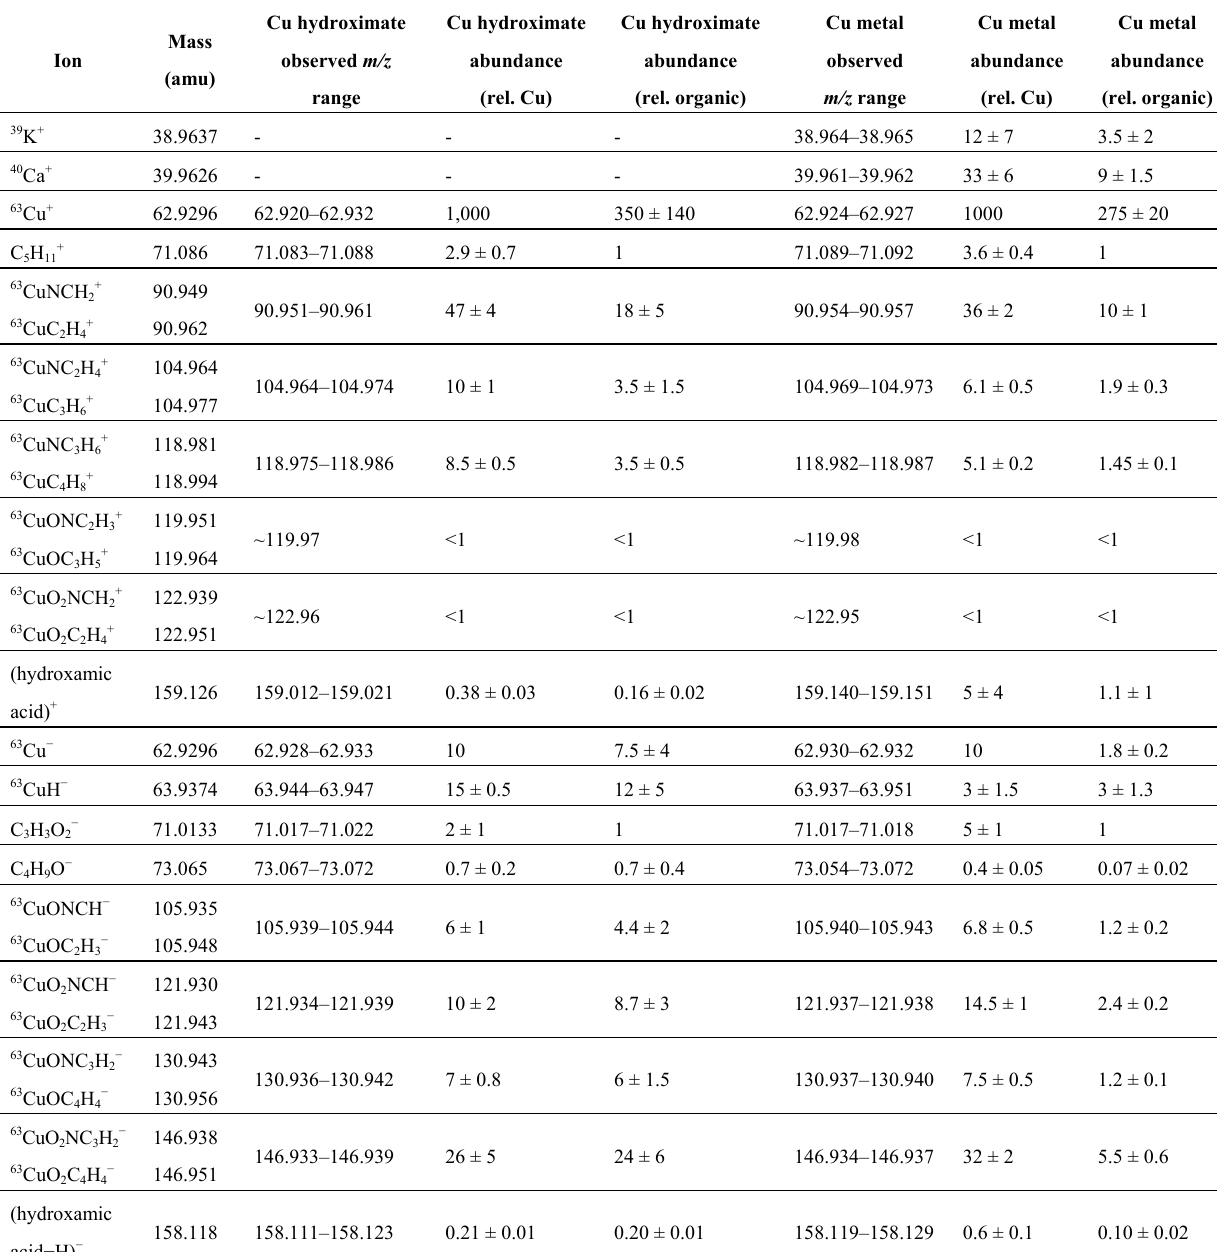
Table 1. Diagnostic ions and their observed m/z and relative abundance ranges for bulk Cu hydroximate and conditioned, air-exposed Cu